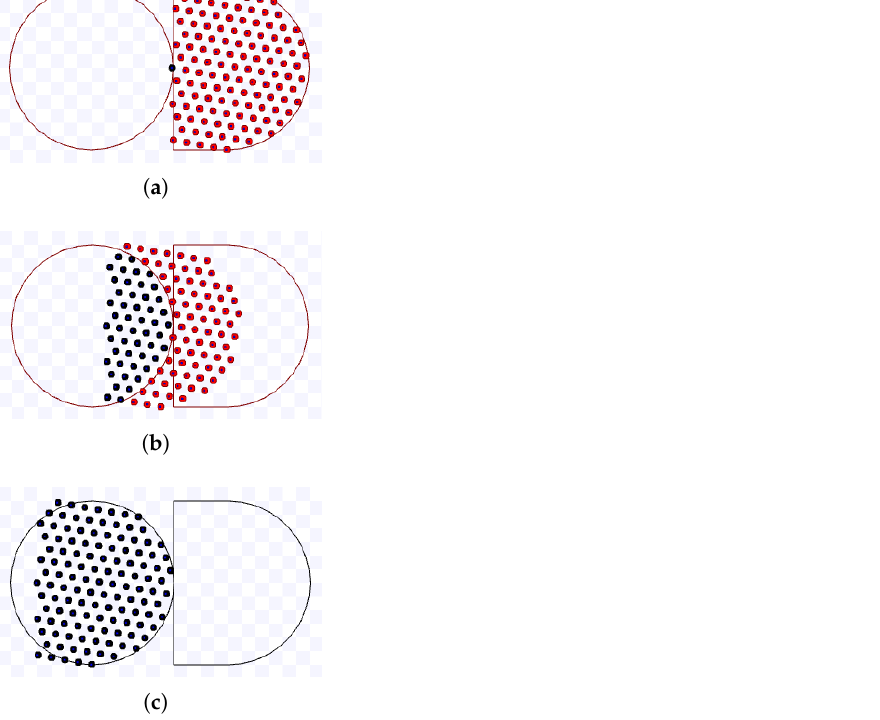
Figure 33. Simulation on Stage for hexagonal packing strategy using s = 6 m, θ = 5 π / 18 during T = 10 s. Available on https://youtu.be/GRYRnH5CrhU, accessed on 12 June 2022. ( a ) 0 s: beginning of the simulation; ( b ) After 4.9 s; ( c ) 10 s: ending of the